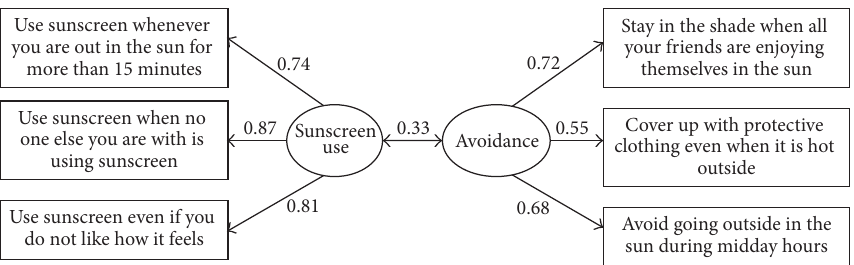
Figure 1: Model with standardized parameter estimates for the total sample ( 𝑁 = 1356 ).